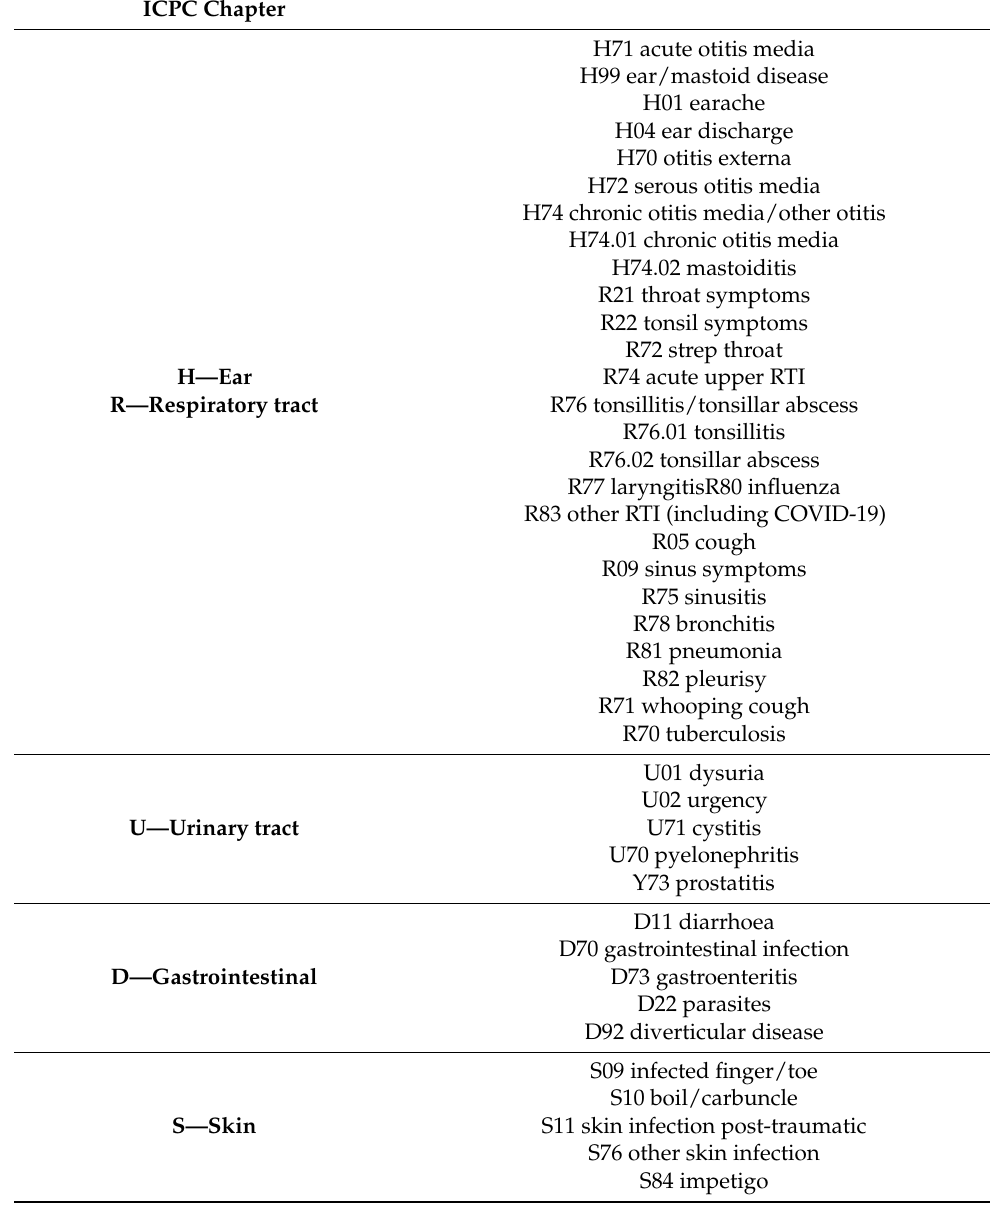
Table A1. ICPC codes used to group consultations into episodes (respiratory tract/ear, urinary tract, gastrointestinal and skin infection